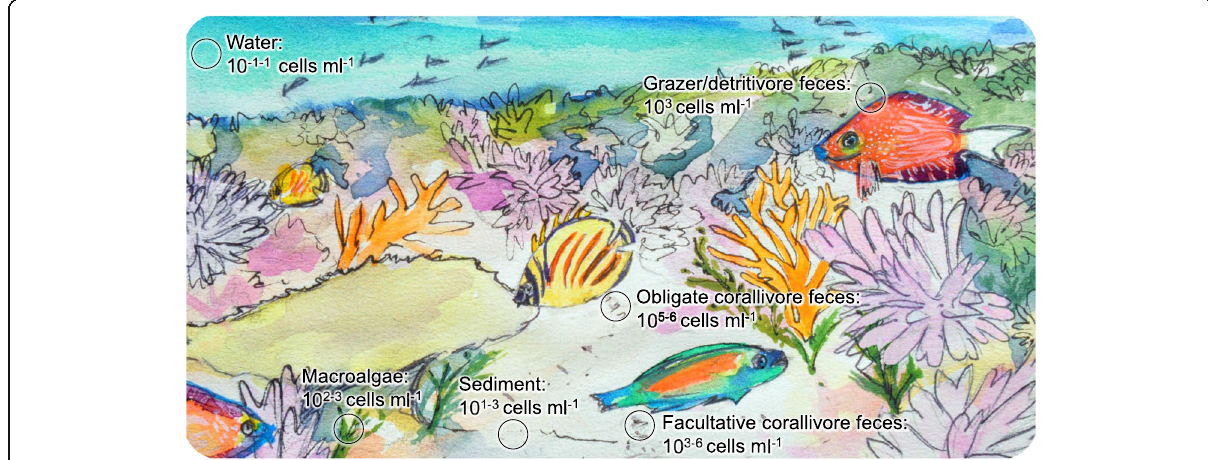
Fig. 1 Summary of the Symbiodiniaceae cell densities quantified from coral reef environmental reservoirs in this and other studies. Cell densities reported in this study (all obligate corallivore and grazer/detritivore feces data and some data for facultative corallivore feces, sediments and seawater) represent live cell densities only, based on results from hemocytometry with the cell viability dye, trypan blue. Previously published cell densities for sediment and seawater [22, 35], macroalgae [22], and facultative corallivore feces [14] may include both dead and live cells and were quantified using hemocytometry [14], a combination of flow-cytometry and hemocytometry [35], or quantitative PCR